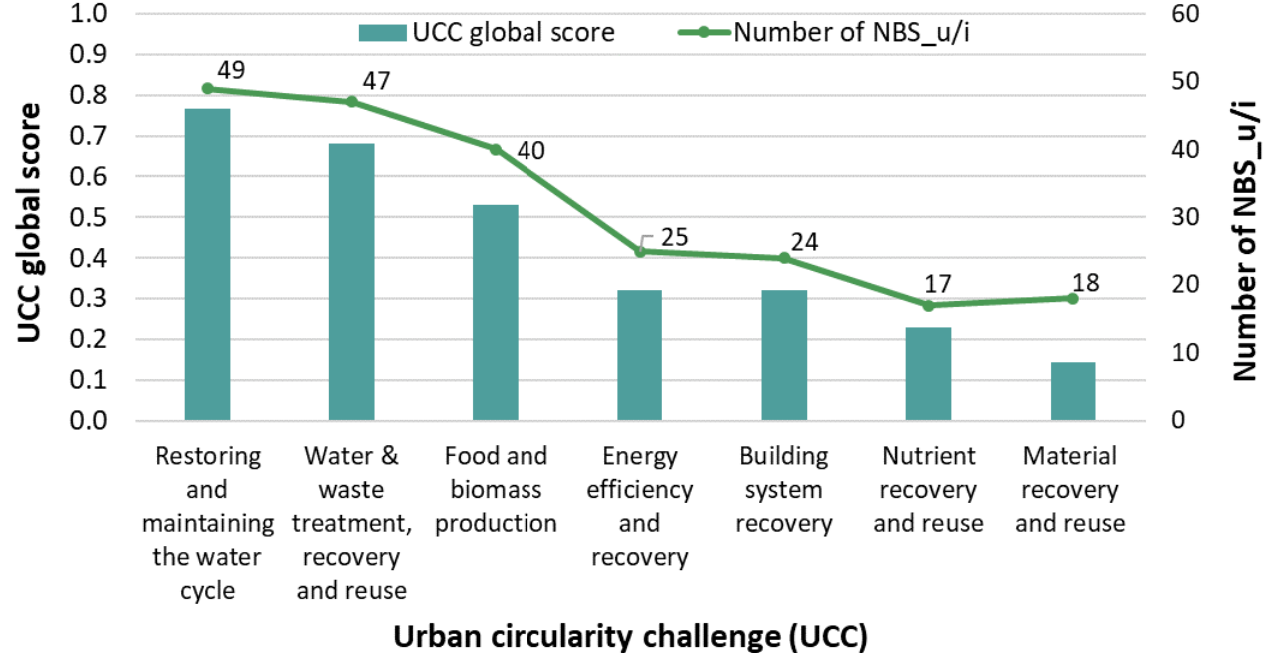
Figure 3. Performance of NSB_u/i in addressing Urban Circularity Challenges.